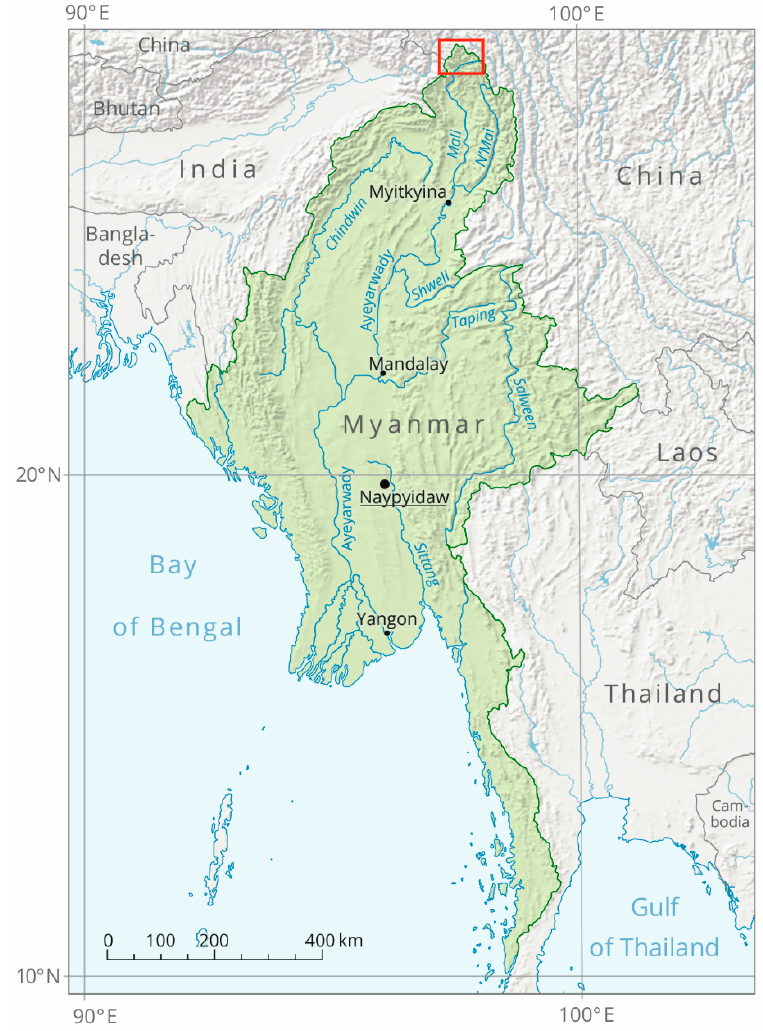
Figure 1. Overview map Myanmar with major rivers and indication of study region (red rectangle).